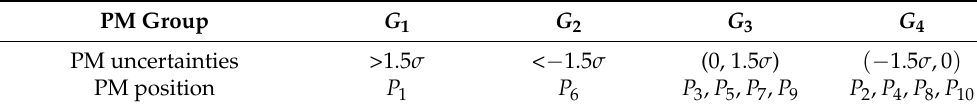
Table 5. The PMs category approach based on the uncertainties